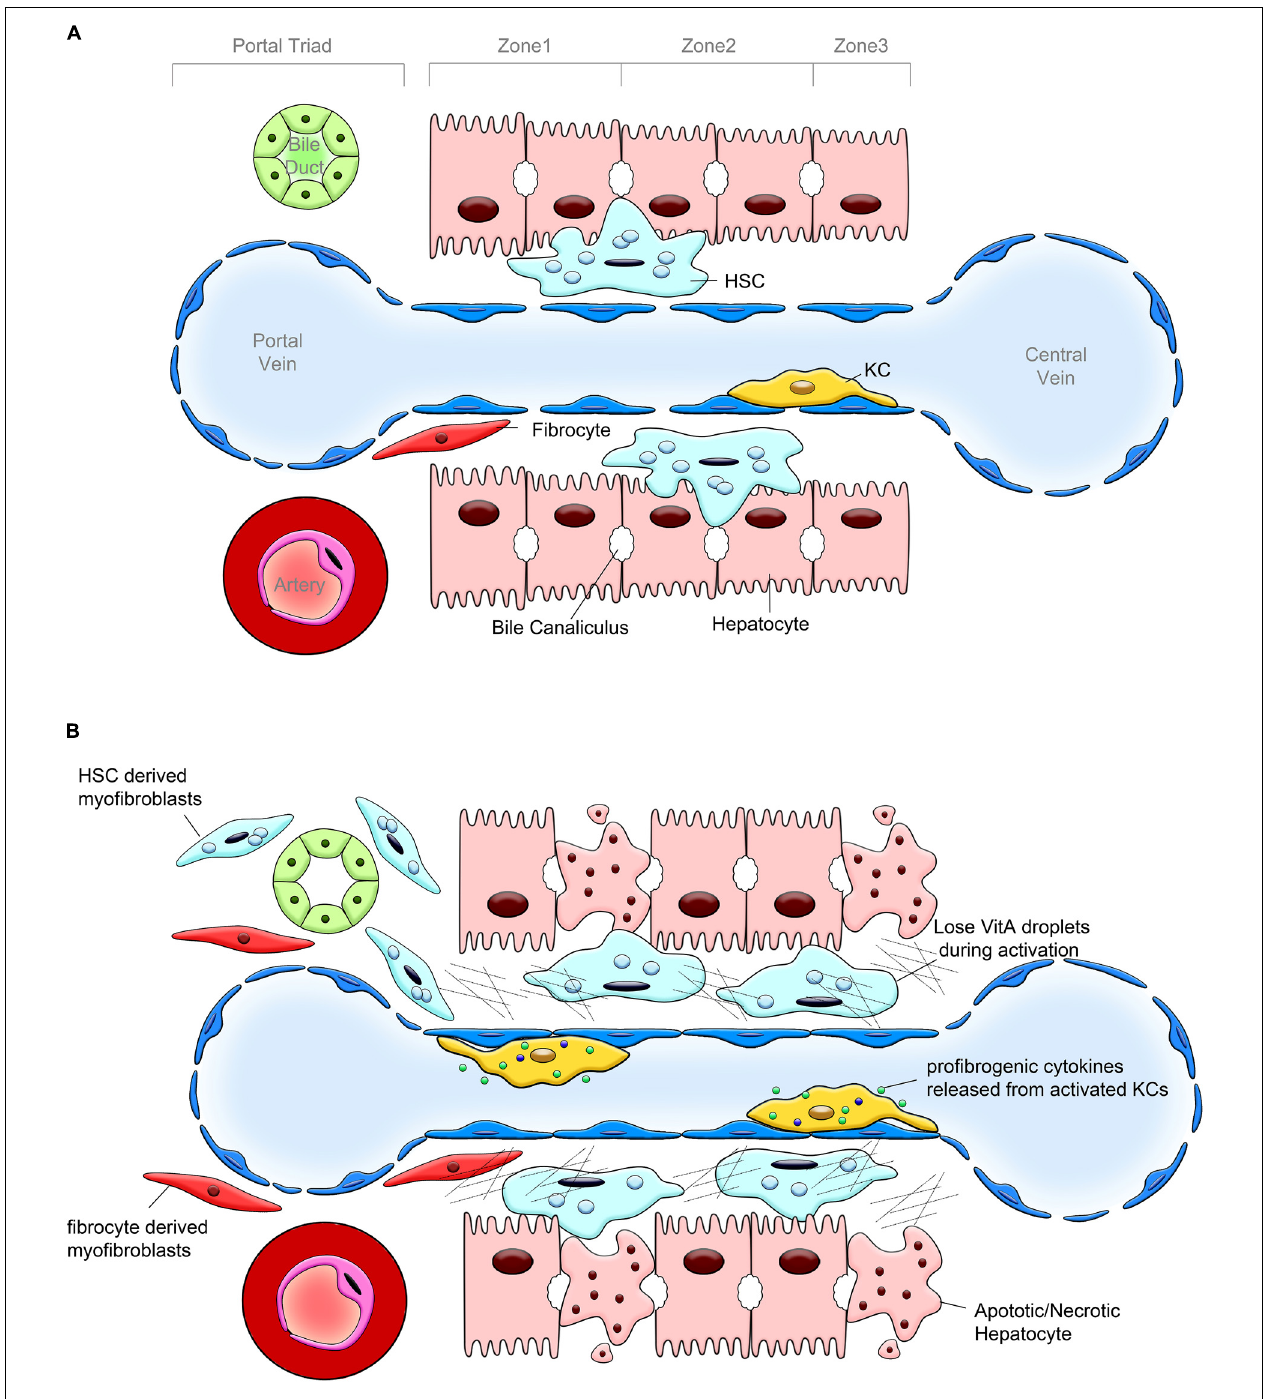
represent a population of hepatic macrophages. Only few fibrocytes are present in the healthy liver. (B) Changes in the hepatic lobule caused by chronic liver injury. In response to chronic liver injury, hepatocytes undergo apoptosis and release factors that recruit Kupffer cells, BM macrophages, and fibrocytes into the damaged liver. KCs, BM macrophages, and fibrocytes releaseTGF β 1, the most potent profibrogenic cytokine, which activates HSCs into collagenType I expressing myofibroblasts. HSCs, PFs and, to a lesser extent fibrocytes, deposit extracellular matrix